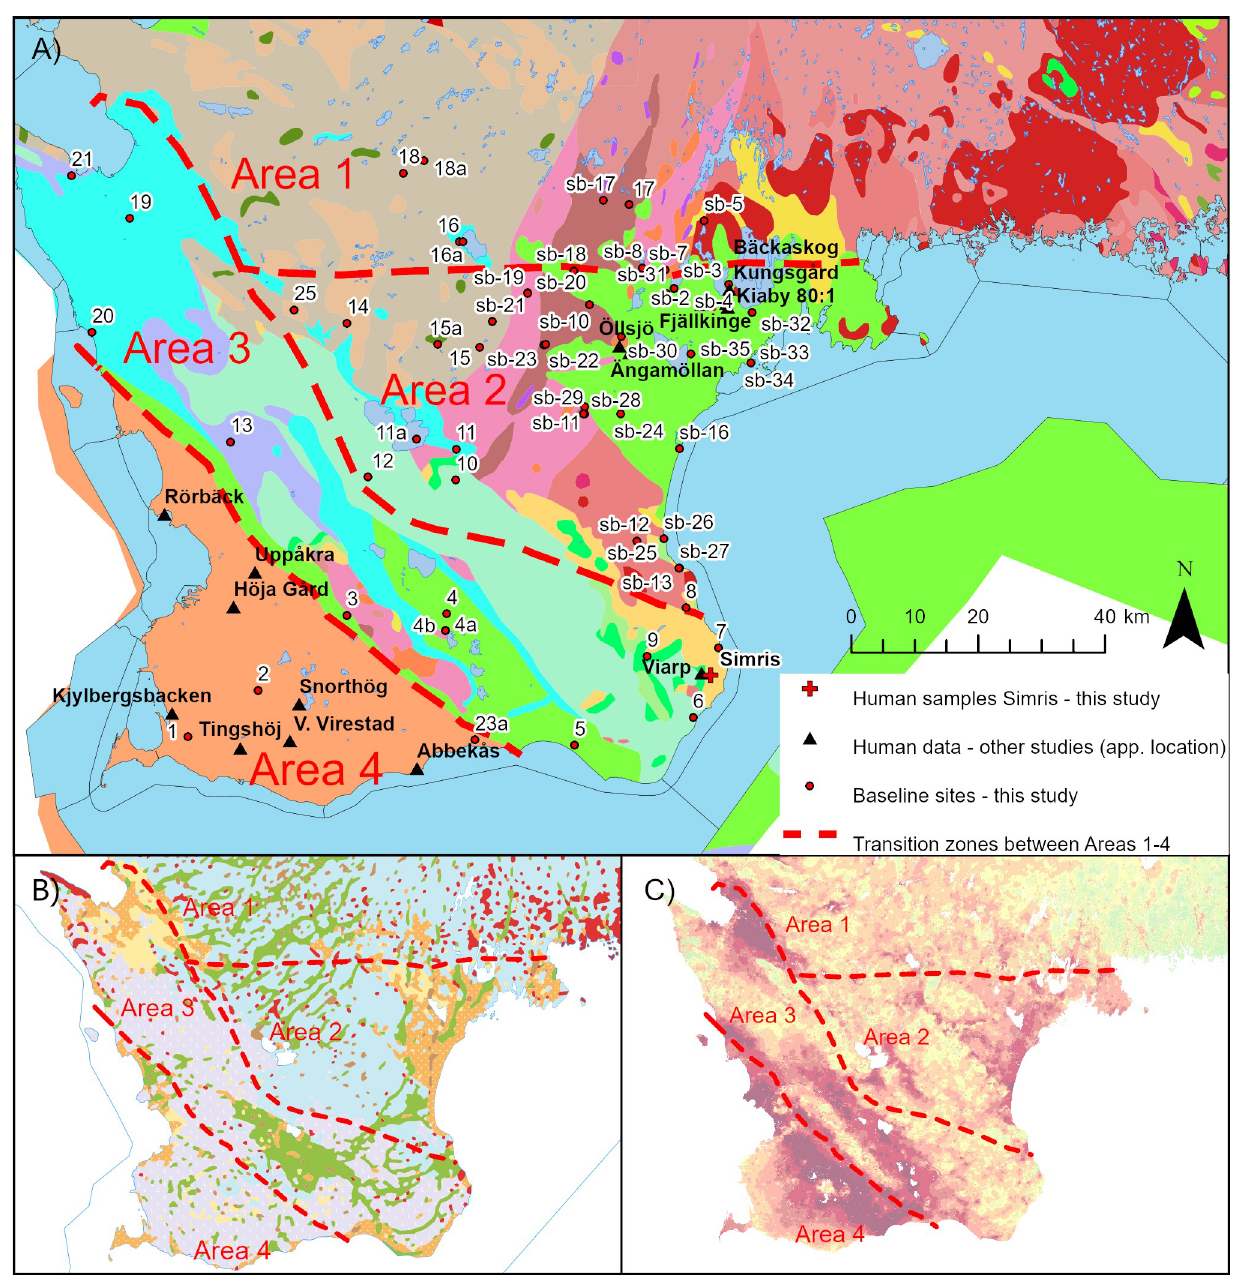
Fig 7. Maps of the three sub-areas (Areas 1, 2 and 3–4) of the Scania region for which individual multi-proxy baselines are presented. Border zones should be interpreted as transition zones, illustrating the gradual nature of the transition between zones characterised by different Sr isotope ranges. Maps show approximate site locations of excavation sites of humans from Late Neolithic and Early Bronze Age sites (Ba¨ckaskog Kungsg å rd, Kiaby, Kiaby Mosse, O¨llsjo¨, A¨ngamo¨llan, Viarp, Ro¨rba¨ck, Ho¨ja G å rd, Kjyllbergsbacken, Snortho¨g, Tingsh ø j, V.Virestad and Abbek å s [13], Iron Age site (Upp å kra [15]), and Late Bronze Age site from Simris II (this study). References and legends of thematic maps shown on Figs 3 and 4. 3. For this reason, we merged Area 3 and 4 into one geographical entity, covering approxi- mately 4700 km 2 , with a spatial sampling density of approximately 1 site pr. 310 km 2 (15 sam- pling sites; 39 multi-proxy samples). The grouped data are plotted as box-and-whiskers diagrams alongside multi-proxy baseline constraints of each group (Fig 8). A thorough